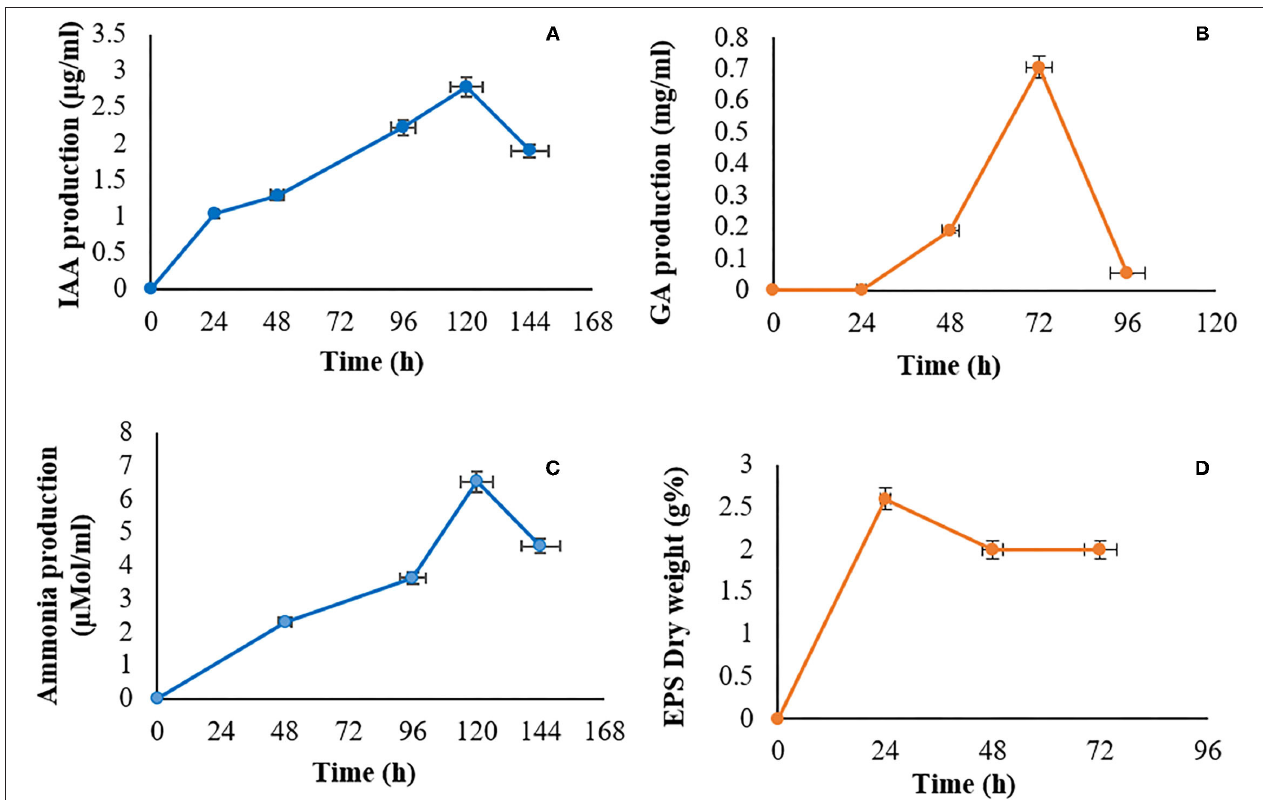
FIGURE 3 | (A) Indole acetic acid production, (B) Gibberellic acid production, (C) Ammonia production, (D) Exopolysaccharide production.